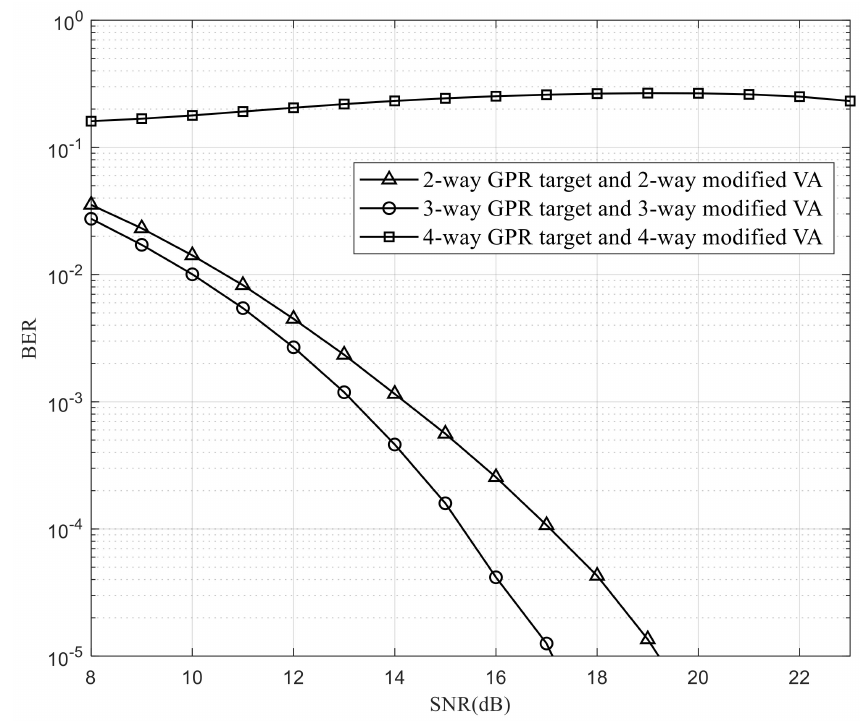
Figure 11. Combined N-way GPR target and N-way MVA for the data in the first